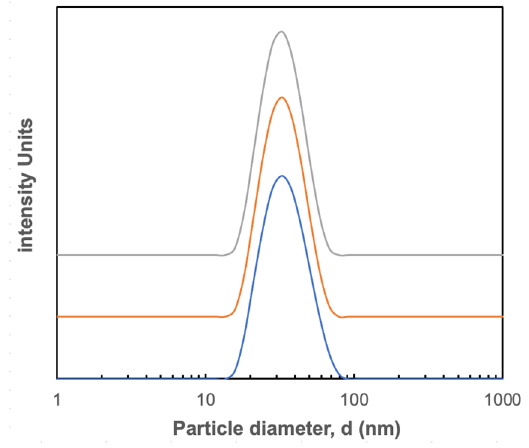
Figure 1. Intensity distribution of blue polystyrene nanoparticles determined using dynamic light scattering. Different color curves are shown for 3 repeat measurements with the y-axis displaced to improve clarity.